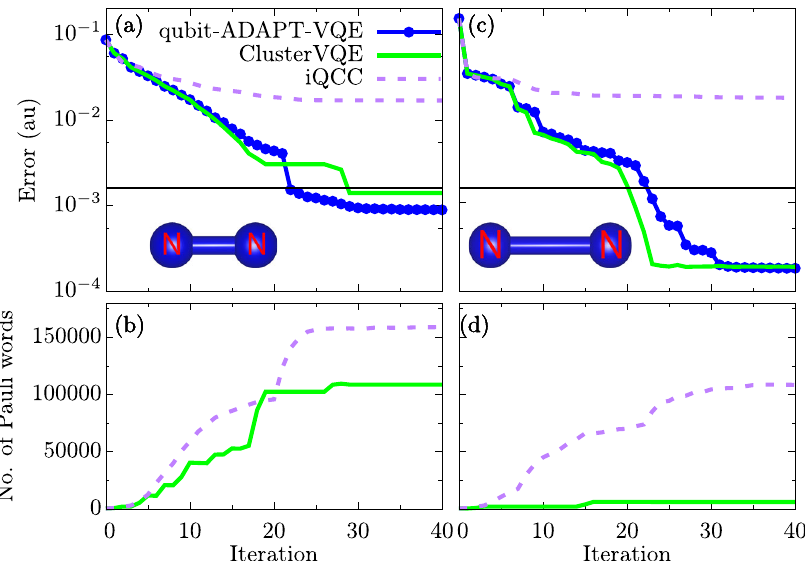
Fig. 4 N 2 simulation. a , c GS Energy errors and ( b , d ) number of Pauli words per each iteration for the N 2 molecule obtained from the qubit- ADAPT-VQE (blue), iQCC (purple) and ClusterVQE (green) methods. The N-N bond lengths are 1.09 Å ( a , b ) and 1.6 Å ( c , d ), respectively. The numbers of Pauli words in the qubit-ADAPT-VQE are 539 and 383 for 1.09 Å and 1.6 Å, respectively, which are not shown in ( b ) and ( d ).